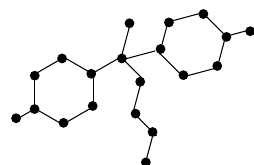
Figure 14. The graph of H of polyther dendrimer PD 3 [ n ] .